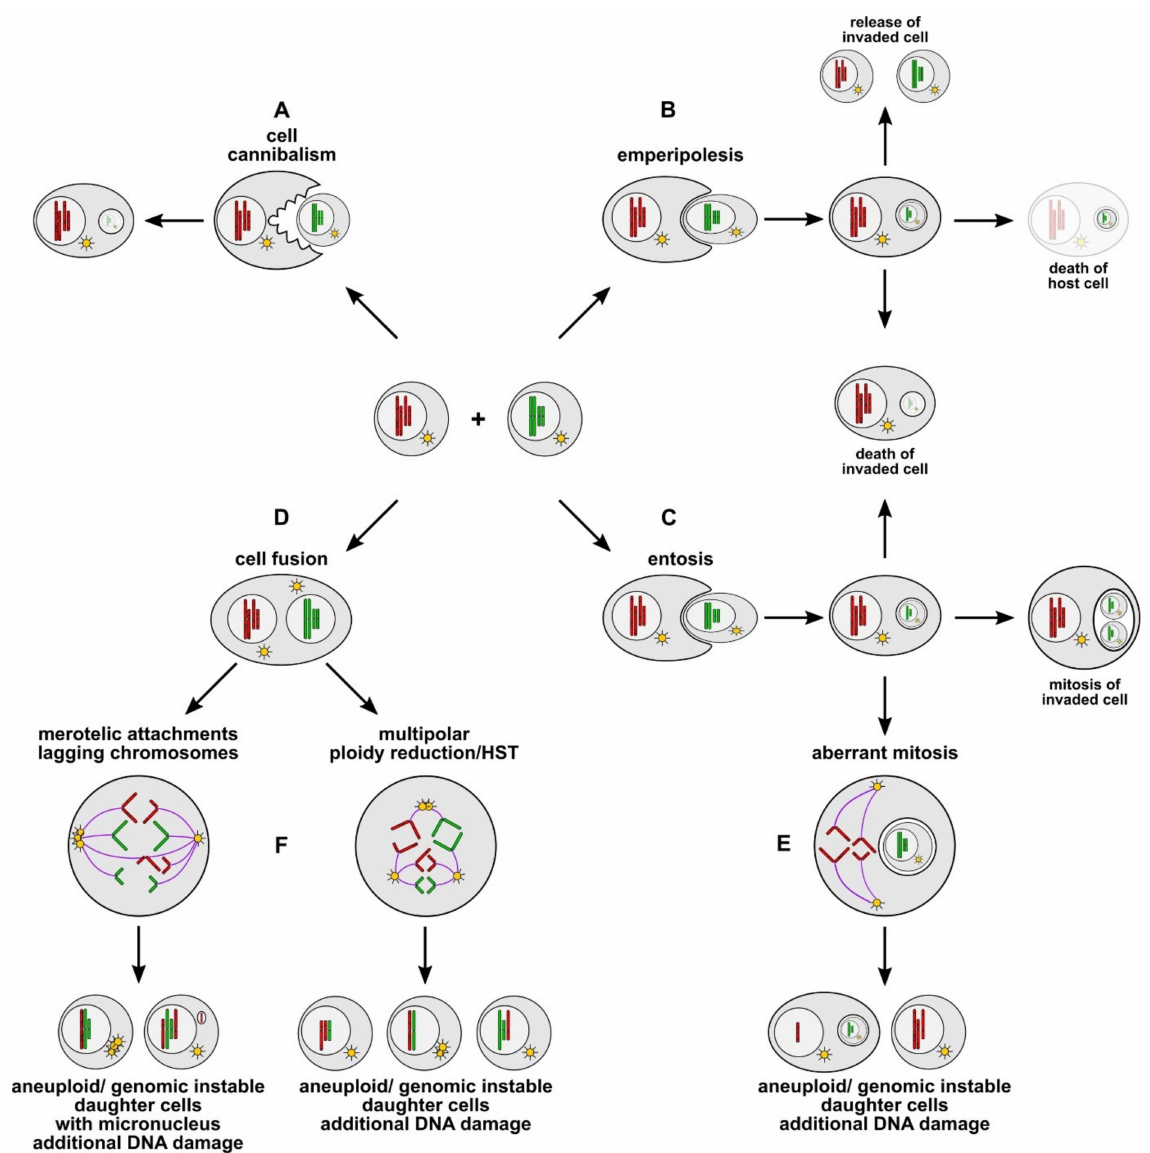
Figure 2. Different fates of merged cells. Cell cannibalism ( A ), emperipolesis ( B ), and entosis ( C ) belong to the so-called cell-in-cell phenomena, which are characterized by the engulfment of intact cells. In contrast, cell fusion ( D ) gives rise to bi- or multinucleated heterokaryons due to merging of the cells’ plasma membranes. Cell cannibalism ( A ) resembles “phagocytosis” and usually results in the lysosomal digestion of the engulfed cell. In contrast, in emperipolesis ( B ) and entosis ( C ) one cell actively invades another cell, whereby the fate of the engulfed cell differs markedly between processes. Emperipolesis is characterized by cells either escaping from the host cell, being destroyed by the host cell, or vice versa destroying the host cell ( B ). On the contrary, most entotic cells are usually destroyed by lysosomal degradation, whereas some internalized cells may also survive and can even divide within the host cell ( C ). Moreover, entosis may be associated with aberrant mitosis ( E ) and the origin of aneuploid and genomic instable daughter cells. A characteristic of hybrid cells is the merging of parental chromosomes and their random segregation to daughter cells during bi- and multipolar divisions ( F ), which is also associated with aneuploidy, genomic instability, and micronucleus